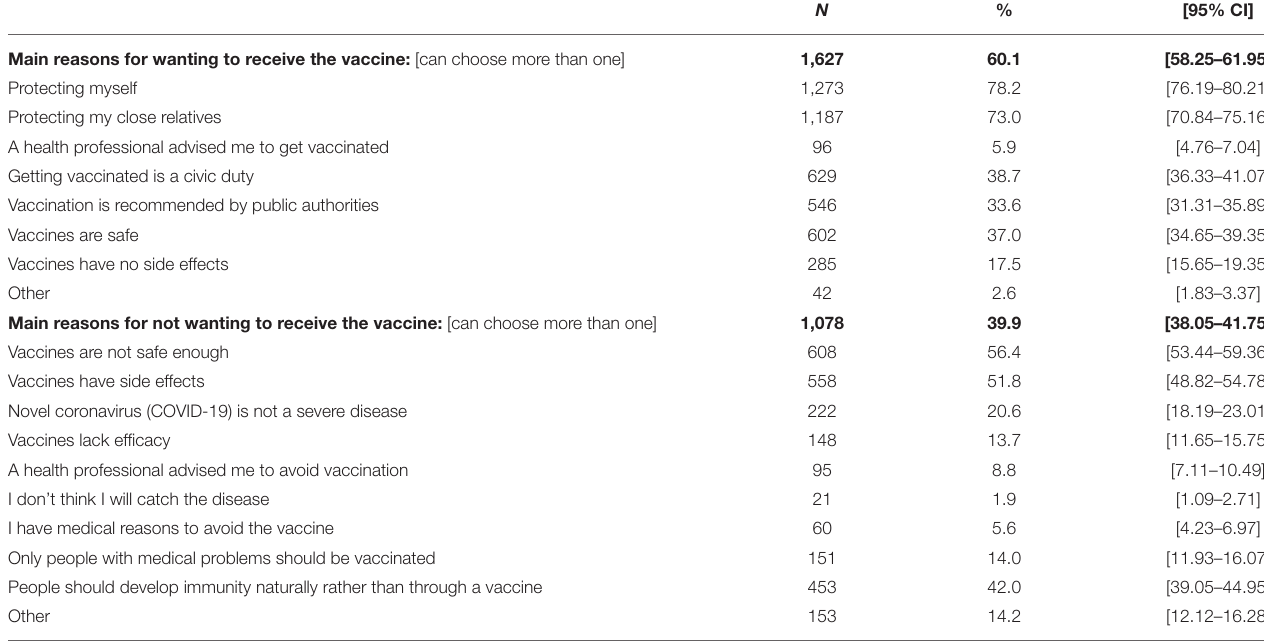
TABLE 2 | The main stated reasons for wanting or not wanting to receive COVID-19 vaccination in the future ( n =